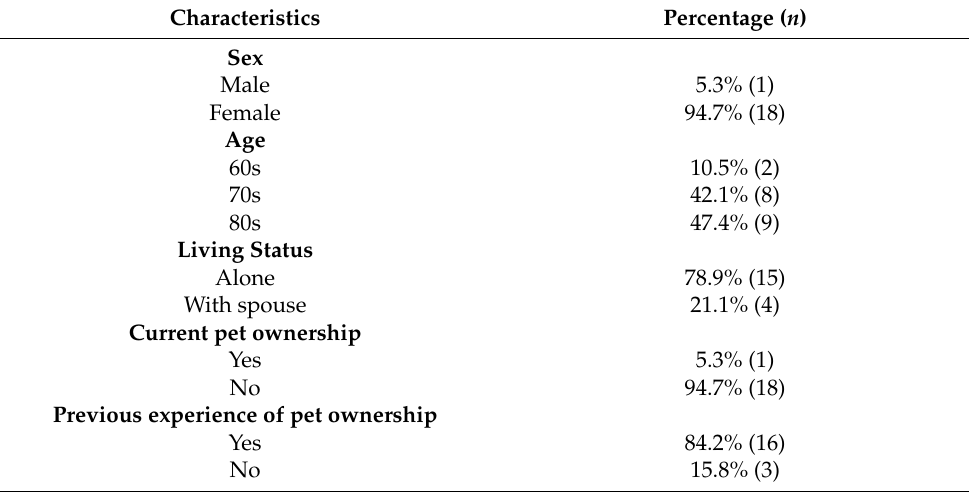
Table 1. Participant Characteristics (N =